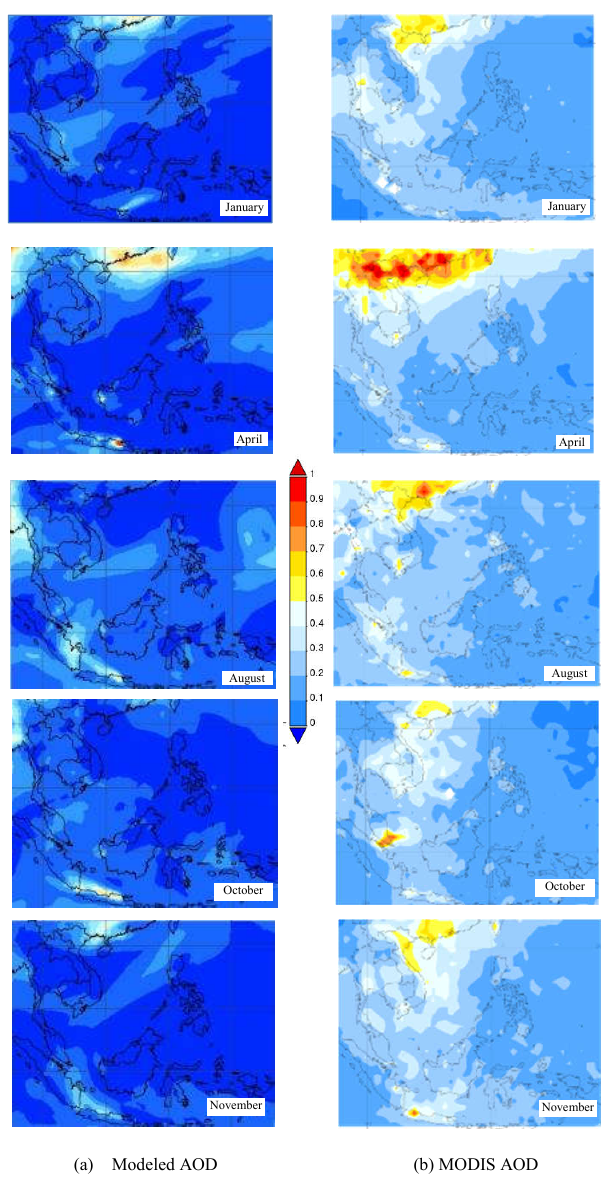
Figure 8. Spatial distribution of monthly modeled AOD as com- pared to the MODIS Terra AOD for the selected months,